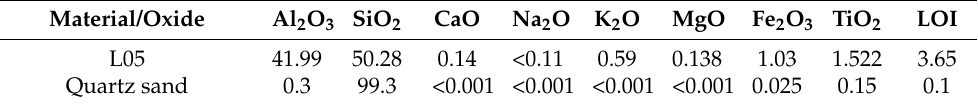
Table 1. Chemical analysis of the industrially supplied raw materials (the main oxides in wt. %). Material/Oxide